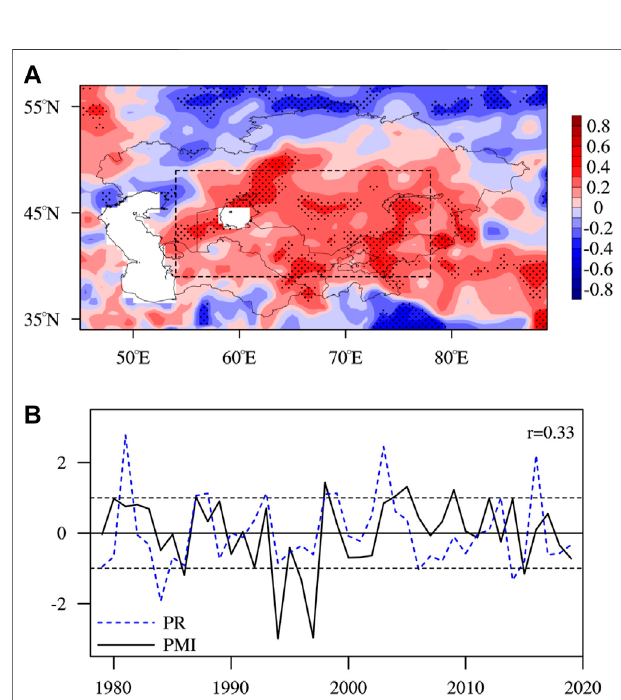
FIGURE 3 | (A) Spatial distribution of the correlation coef fi cient between the TP monsoon index and summer precipitation. (B) Time series of the TP summer monsoon index and summer precipitation in Central Asia. The rectangular lines in (A) indicate the regions selected for the calculation of summer precipitation. The dotted area in (A) is the area that passed the 90% con fi dence level student ’ s